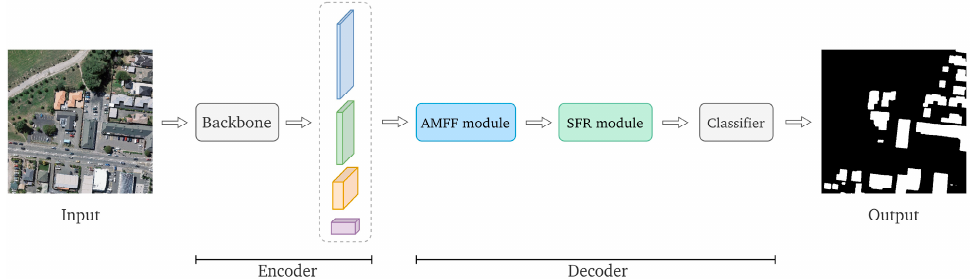
Figure 1. Schematic diagram of the AFL-Net framework. The encoder extracts the features through the backbone, outputting four feature maps at different scales. The decoder fuses the feature maps via the AMFF module, optimizes the building shape features via the SFR module, and outputs the building segmentation mask after the classifier.